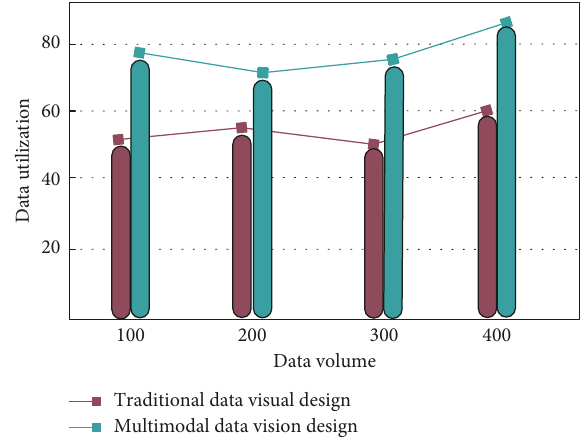
Figure 5: Comparison of utilization of multimodal data and traditional data in visual design